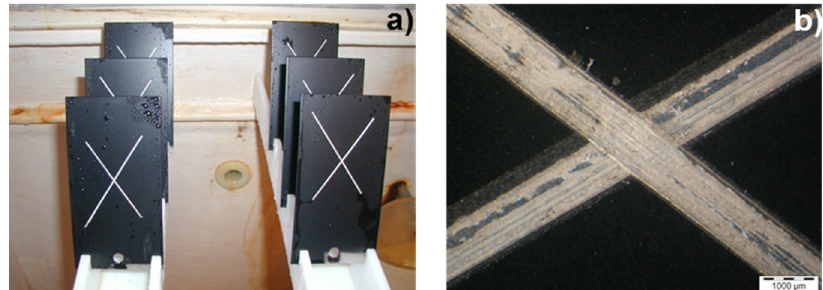
Figure 10. ( a ) Polyester powder coated aluminum alloy 6063 sheets pre ‐ treated with a hybrid sol ‐ gel doped with Ce(III) inhibitor after 1000 hours salt spray (NSS) test (ISO 9227); ( b ) Neither signs of aluminum corrosion outside the scribe, nor signs of blistering or infiltration over the scribe length, were visible on the coating [123].